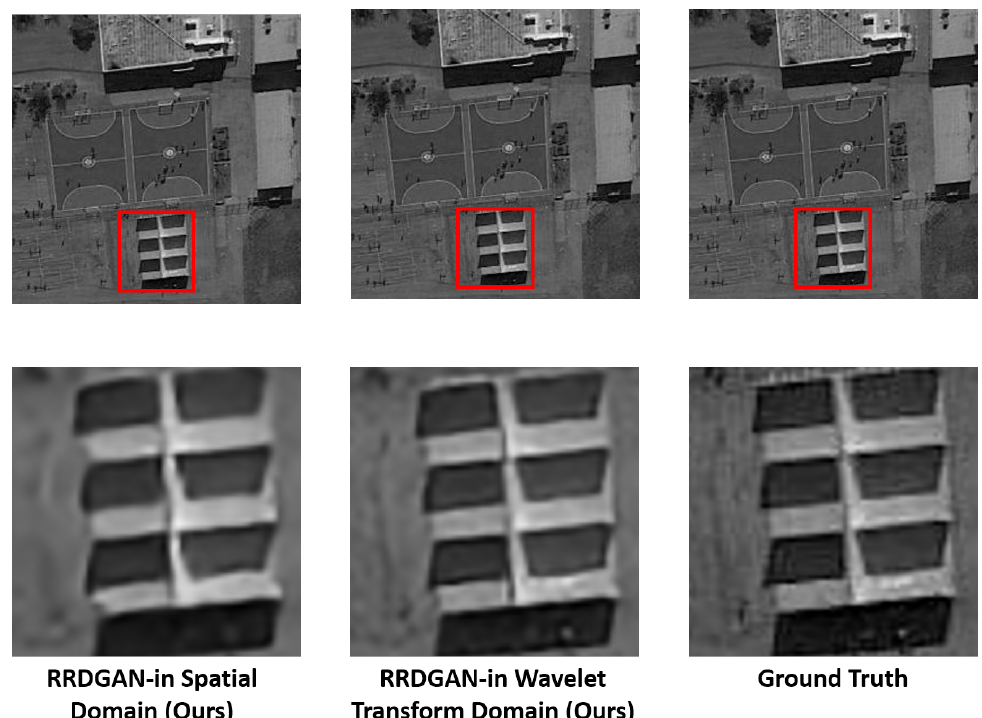
Figure 1. The comparison of implementing our method in WT domain or in spatial